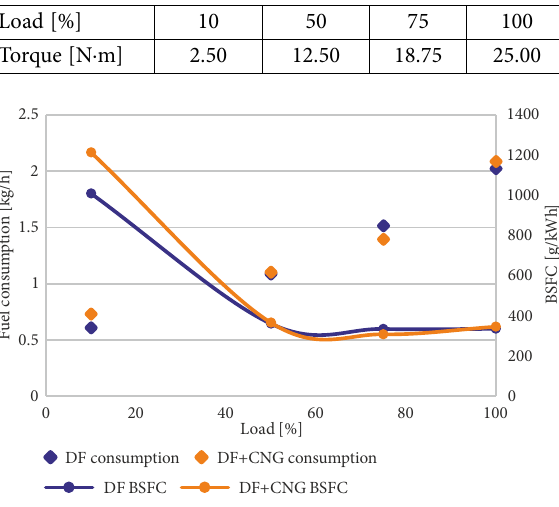
Figure 3. Fuel consumption at workloads of 10, 50, 75 and